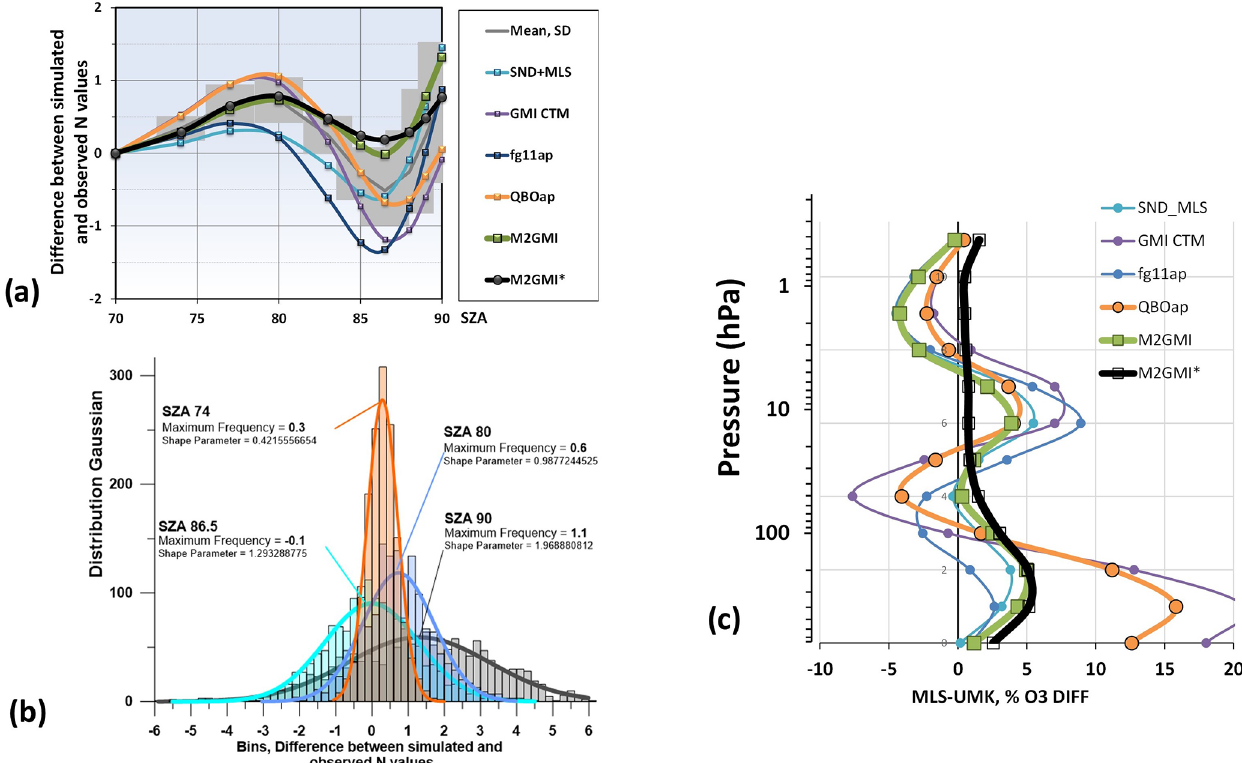
Figure 2. The simulated Umkehr observations are based on the GMI CTM and M2GMI models, MLS satellite overpass and ozonesonde profiles at Boulder, and two ozone climatologies at 40 ◦ latitude (fg11ap and QBOap). (a) Difference between simulated and observed N values at Boulder as a function of SZA. (b) Histogram of the differences between simulated (based on M2GMI data) and observed N values at 74 ◦ (orange), 80 ◦ (purple), 86.5 ◦ (light blue), and 90 ◦ (dark) SZA. Solid lines are normal distribution fits to the data; the maximum frequency and shape parameters of the fit are provided in the legend. (c) The difference between the MLS and several versions of Umkehr profiles retrieved after applying corrections shown in panel (a) . The final optimized adjustment M2GMI* ( N -value correction is shown in panel a as a black line) is found through the iterative approach to minimize the M2GMI bias.